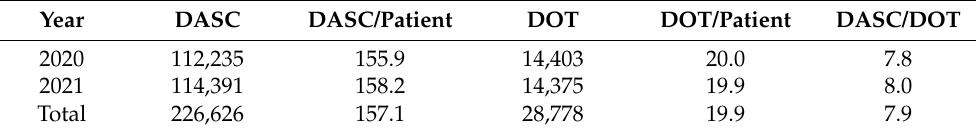
Table 2. The overall DASC and DOT metrics in this study population.